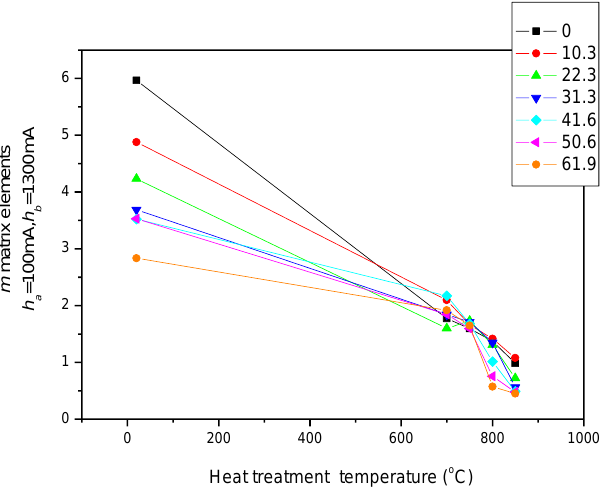
Figure 9. ( h a = 100 and h b = 1300) MAT descriptors of all samples as a function of the temperature of heat treatments. The parameter is the rolling reduction.